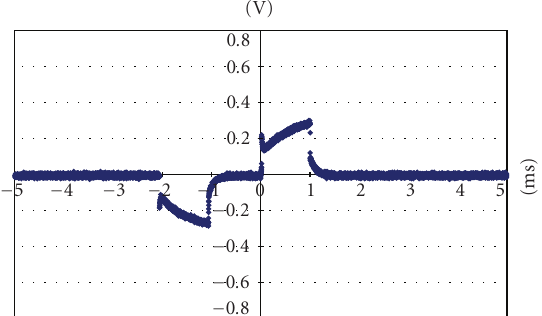
Figure 6: The voltage drop between a strip-shaped electrode (in the suprachoroidal space under visual streak) and the reference elec- trode (on the surface of sclera) with 104uA current intensity (upon implantation.)